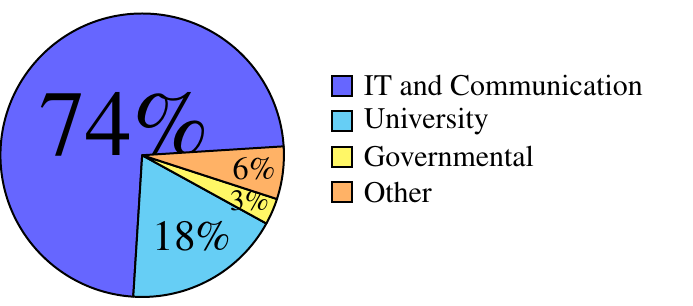
Figure A2. Industries of participants (n =